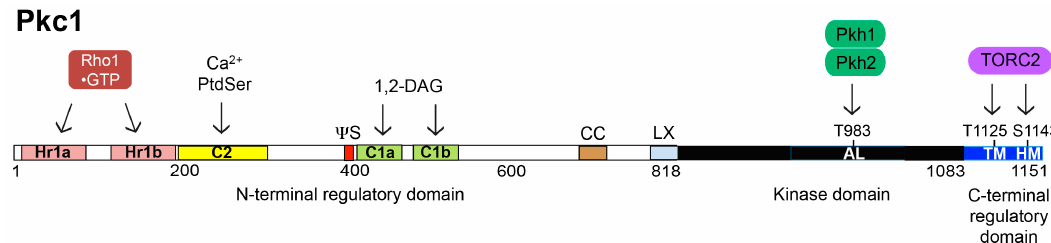
Figure 2. Schematic depiction of the primary structure of Pkc1. Catalytic domain (black) and N- (white) and C-terminal (dark blue) regulatory elements are indicated. Abbreviations: Hr1 (pink), Homology region 1, a compact helical bundle, also referred to as an ACC (anti-parallel coiled-coil) finger domain, which binds small GTPases of the Rho family; C2 (yellow), Conserved region 2, an 8-stranded β -sandwich rich in acidic residues, also referred to as a CalB (Ca 2+ -binding) domain, which binds to phospholipids, especially PtdSer, in a Ca 2+ -dependent manner; Ψ S (red), pseudosubstrate sequence, a short sequence that lacks a phosphoacceptor residue, but otherwise possesses the features of the optimal Pkc1 consensus phosphoacceptor site, which binds to and occludes the catalytic pocket in the kinase domain, thereby keeping the enzyme inactive; C1 (green), Conserved region 1, a Cys-rich Zn 2+ -binding fold with the capacity to bind 1,2-DAG or their pharmacological mimic, phorbol esters; CC (brown), a sequence with a strong propensity to form a coiled-coil, and LX (gray), a low-complexity sequence, as predicted by UnitProt [50] and/or SMART [51] databases; AL, activation loop Thr (T983), phosphorylated by Pkh1 (and Pkh2); TM, turn motif Thr (T1125), and, HM, hydrophobic motif Ser (S1143), both phosphorylated by TORC2.